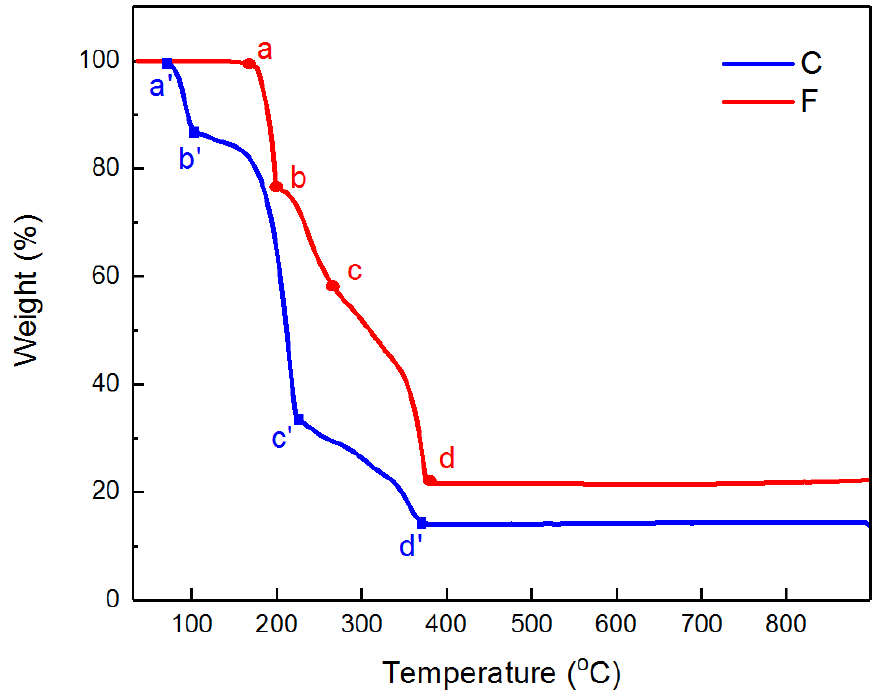
Figure 6. TGA curves of C 15 H 24 FeO 6 (Fe(acac) 3 ) powder (F) and C 15 H 21 CoO 6 (Co(acac) 2 ) powder (C) in air.